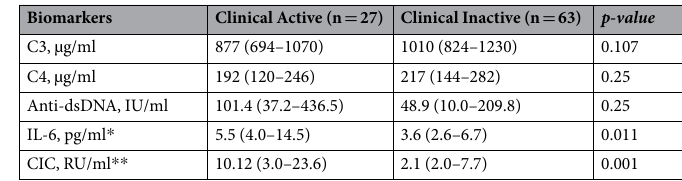
Table 2. Serum biomarkers in the different stages of SLE disease activity. Data showed in median (IQR). * p < 0.05, ** p < 0.01.